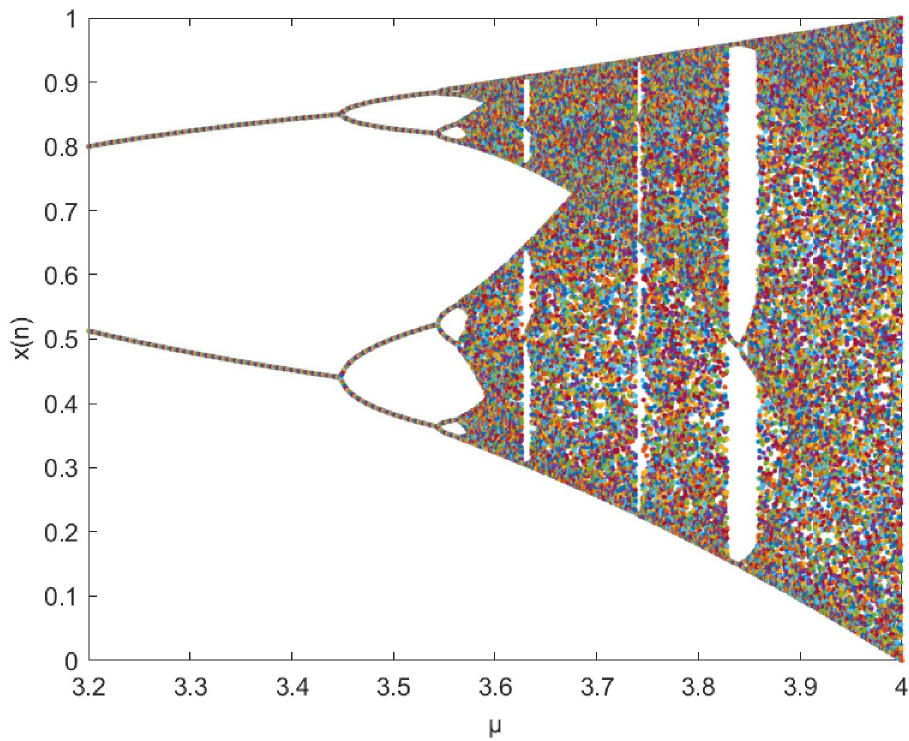
Fig 1. Logistic chaotic bifurcation